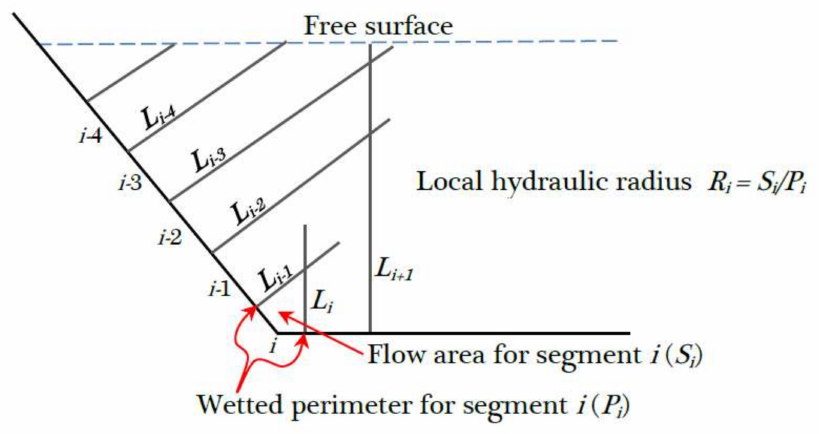
Figure 6. Schematic illustration of the areas determined by the merged perpendicular method